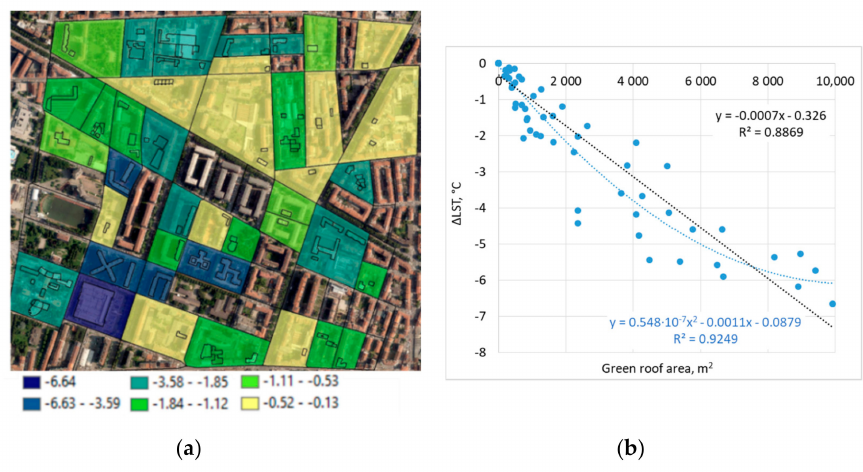
Figure 8. Green roofs’ potential assessment at block-of-building scale: ( a ) Thermal condition assessment, Land Surface Temperature ( LST) variation before and after the installation of green roof technologies; ( b ) correlation between the LST variation and the quota of green roof